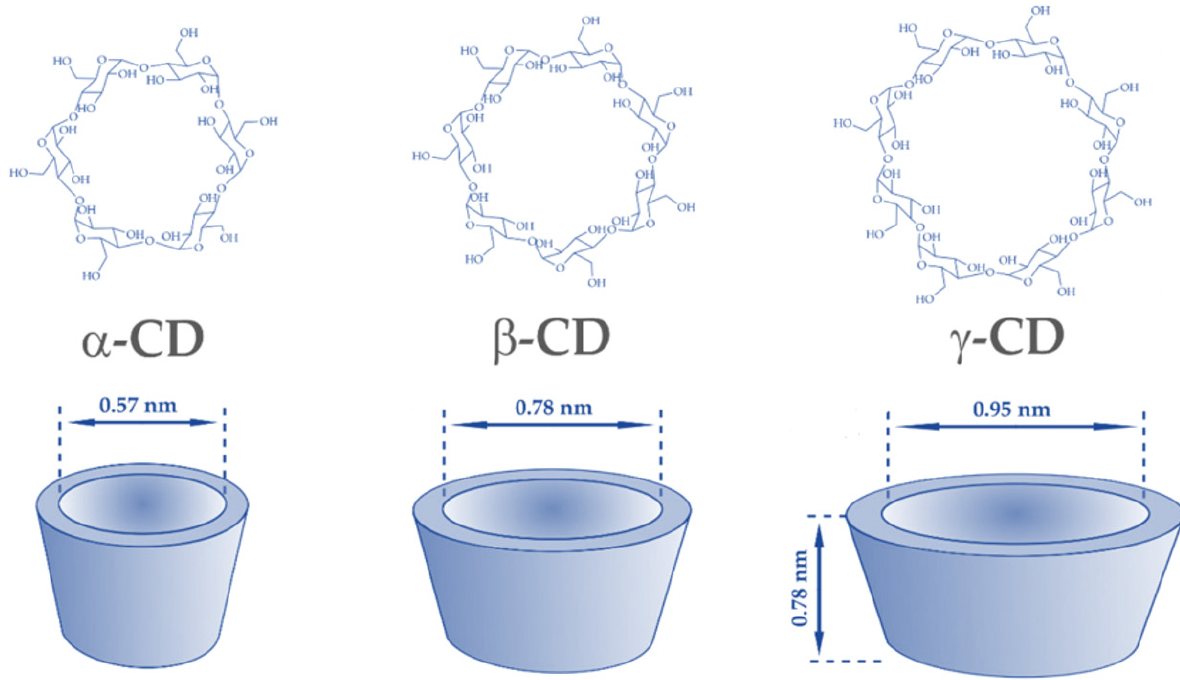
Figure 1. α -, β -, and γ -CD (cyclodextrin) molecules. Adapted from an open-access source [27].